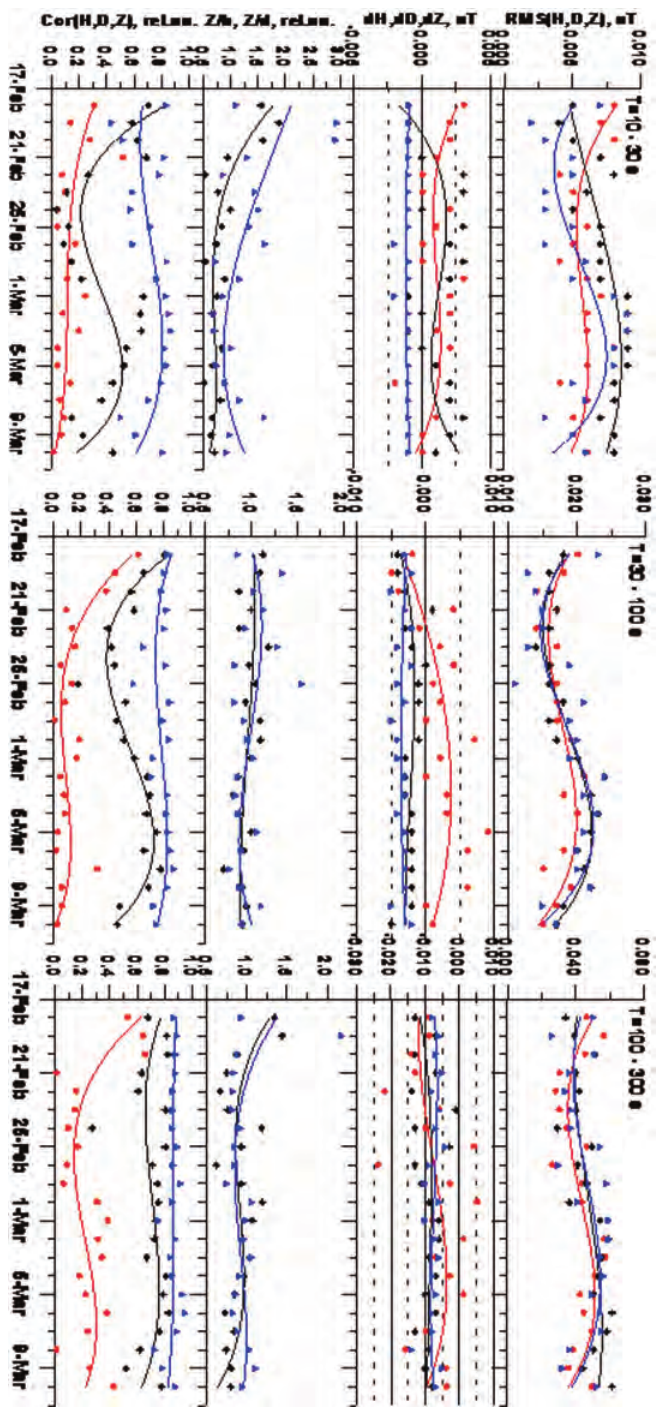
Figure 4. RMS of the three magnetic components (Kakioka observatory) during the period of February 18, 2011 to March 10, 2011 (top curves). Differences (dH, dD, dZ) of the corresponding magnetic components of a pair of remote magnetic stations (Kakioka-Uchiura, second from top). Cor(H,D,Z), as the correlation coefficients of the corresponding magnetic components of the Kakioka and Uchiura stations. Blue squares, H; black crosses, D; and red circles, Z component. Ratios Z/h (blue squares) and Z/d (black crosses), vertical component divided by the horizontal one (Kakioka, second from